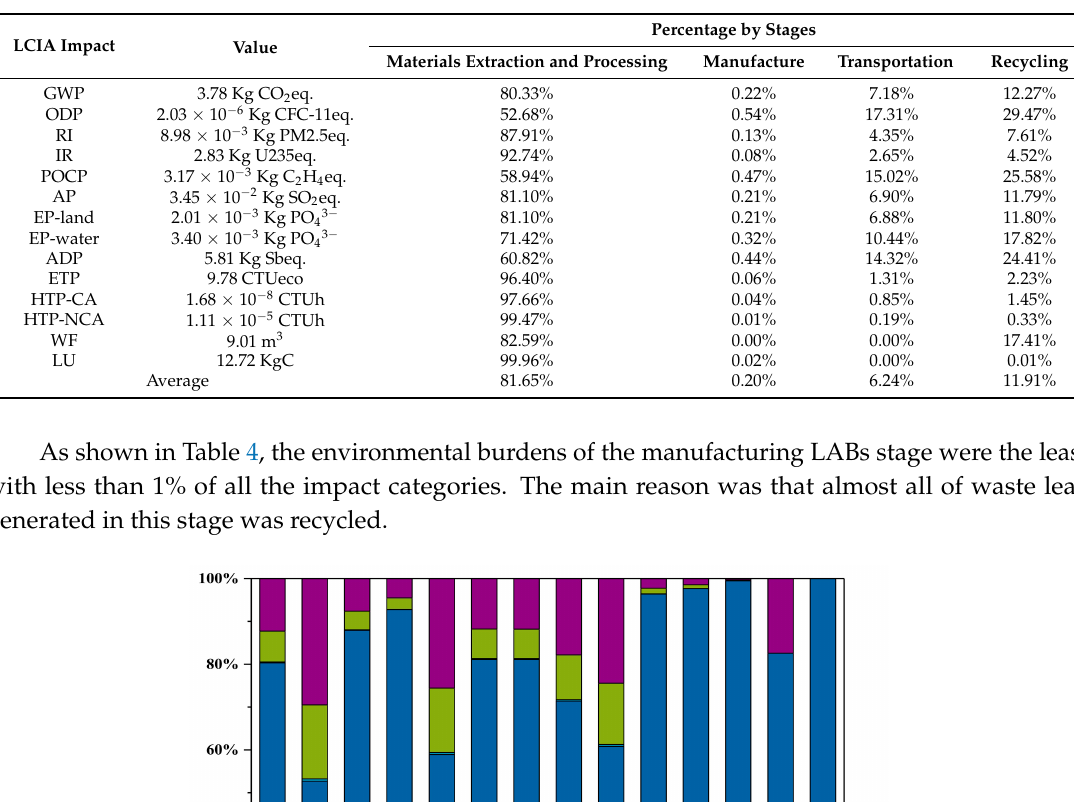
Table 4. The life cycle burdens for 1 KVAh capacity of LABs.